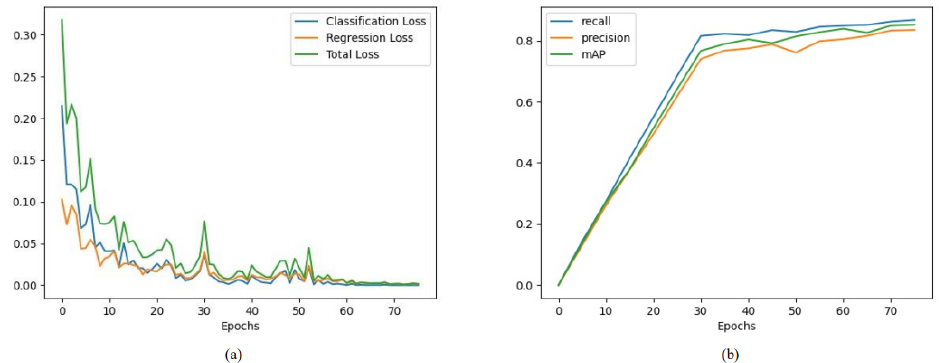
Figure 12. The learning curve on the HRSID dataset. ( a ) The relationship between classification loss, regression loss, total loss and epoch. ( b ) The relationship between the precision, recall, mAP and